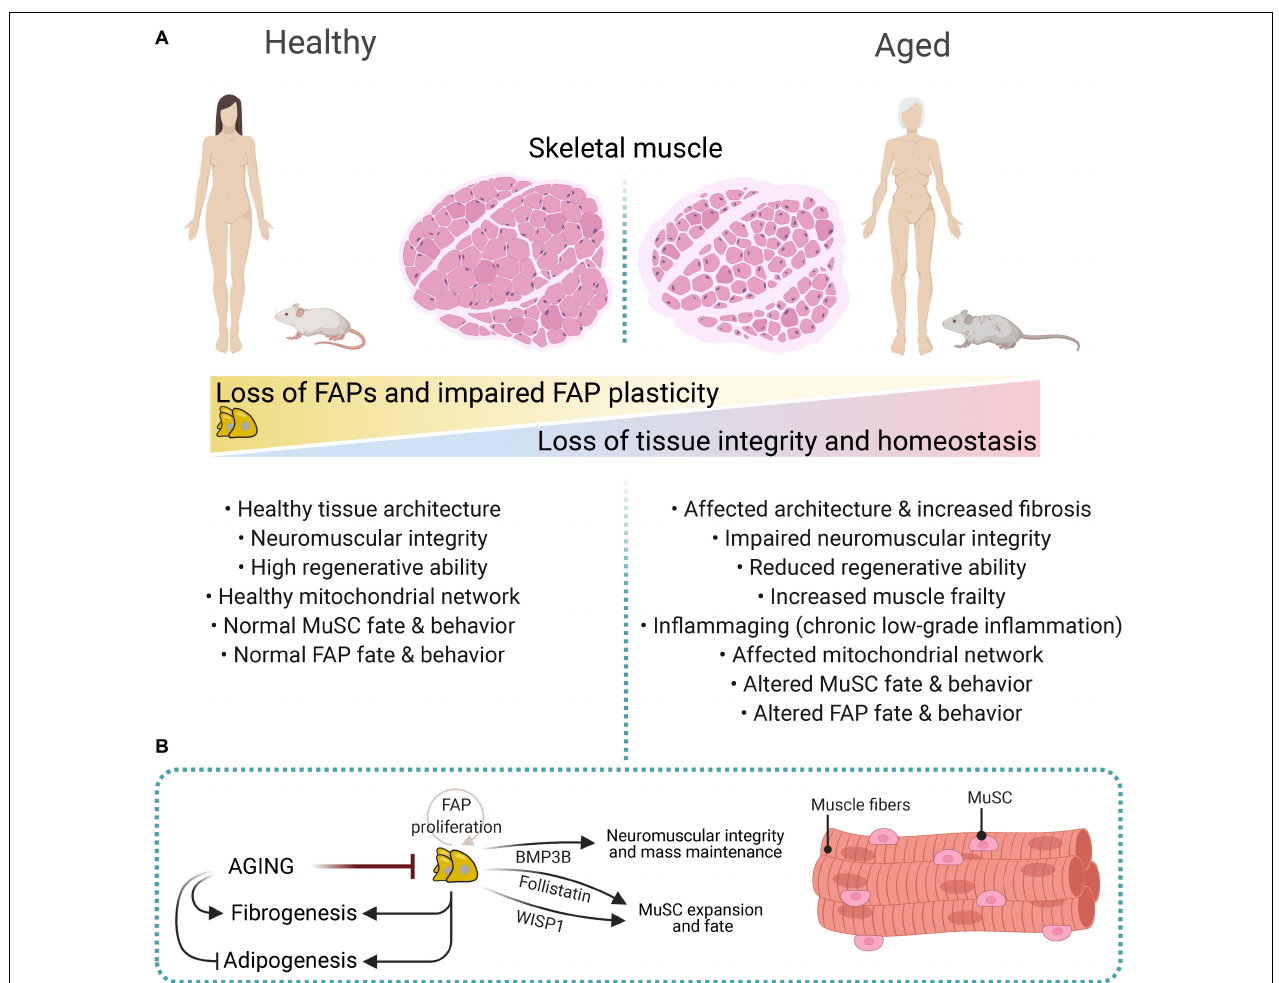
FIGURE 5 | Impaired FAP numbers, behavior, and fate in aged muscles. (A) Sarcopenic and cachexic muscles have altered muscular integrity and structure, impaired neuromuscular communication, reduced regenerative capacities, enhanced fibrosis, and altered FAP number, fate, and behavior. These structural, cellular, and molecular age-related changes are associated with increased muscle frailty and muscle mass loss. (B) FAP-derived molecules regulate neuromuscular integrity, muscle mass, and MuSC expansion and fate. These include Follistatin, WISP1, and BMP3B. Aging impairs FAP proliferation and expansion, whereas it promotes fibrogenesis over